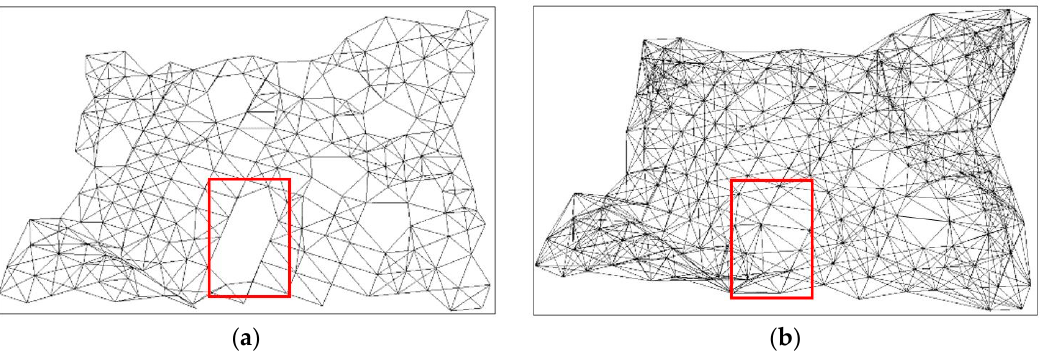
Figure 4. SIGs constructed using: ( a ) the original method and ( b ) our method.